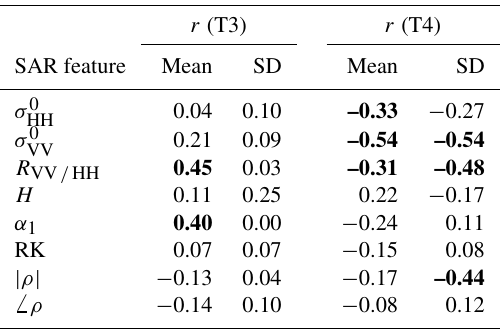
Table 4. Spearman’s correlation coefficient ( r ) between f MP re- trieved from the helicopter images at the investigated floe, and mean and standard deviation of the polarimetric SAR features from the corresponding area in T3 and T4. Bold indicates significant values within a 95% confidence